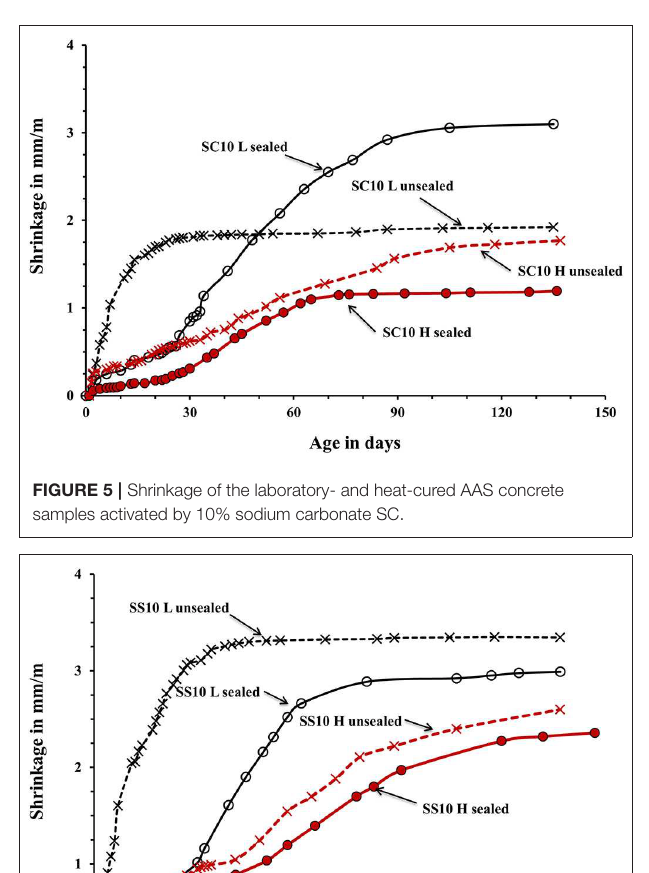
wt.% SC + 5 wt.% SS, subjected to the same curing